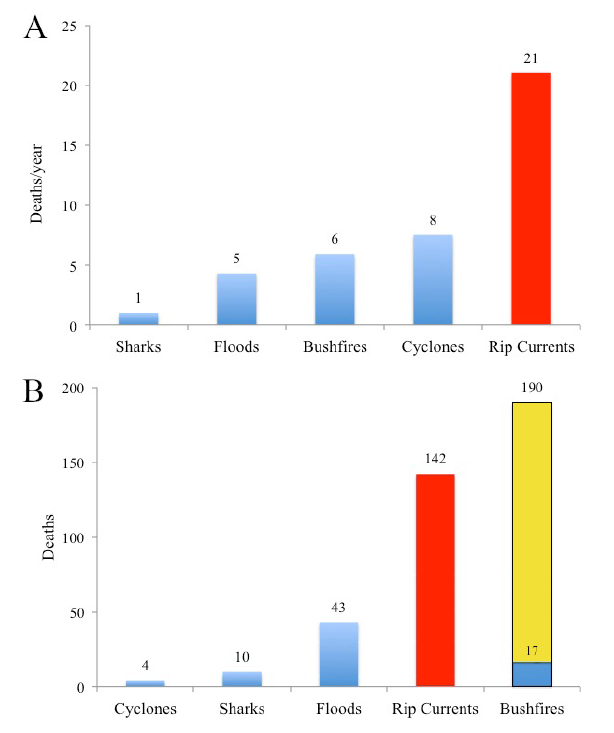
Fig. 1. A comparison of average annual fatalities by natural hazards in Australia for (a) the longest available datasets and (b) the over- lapping period 2004–2011. Note that the yellow band corresponds to fatalities in a single bushfire event on 9 February